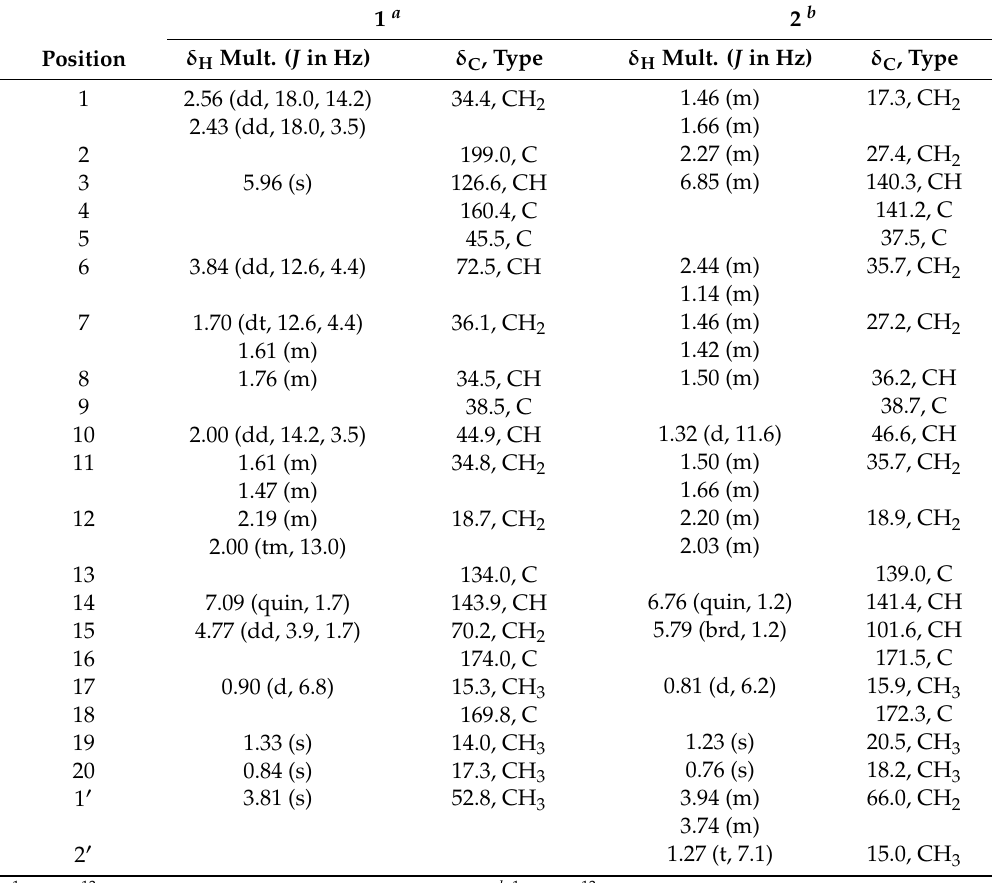
Table 1. 1 H and 13 C NMR Data of compounds 1 and 2 in CDCl 3